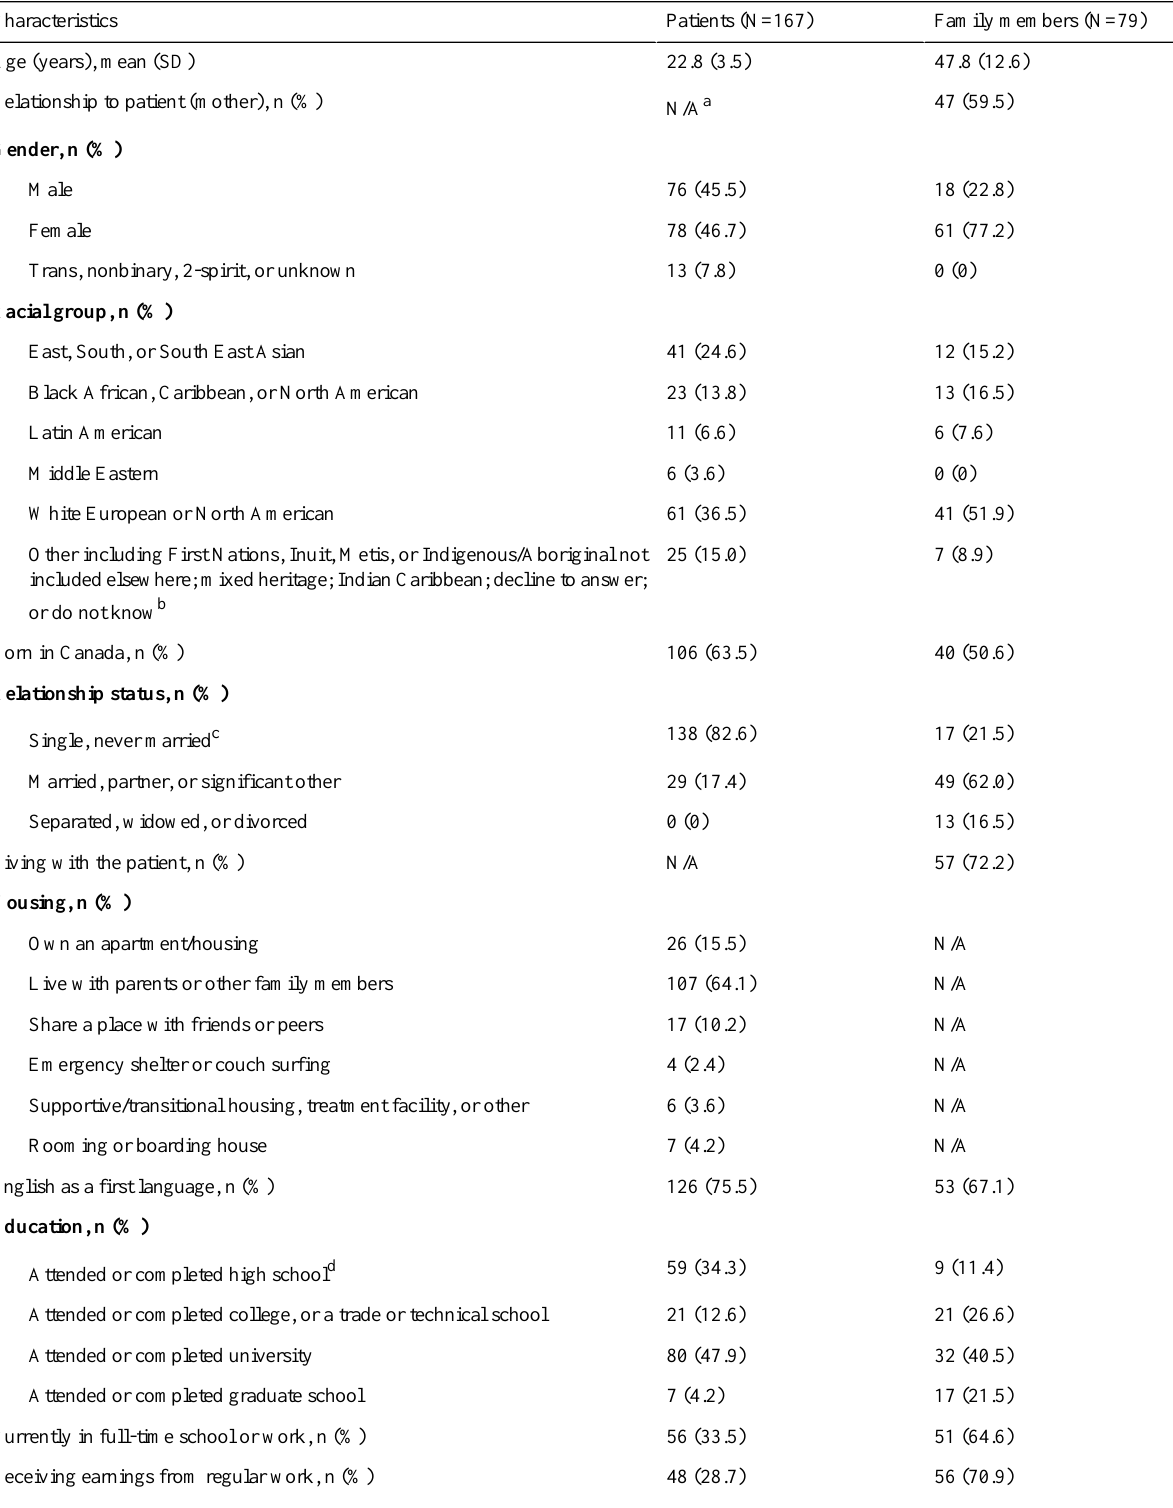
Table 2. Demographic characteristics of patients and family members who completed the